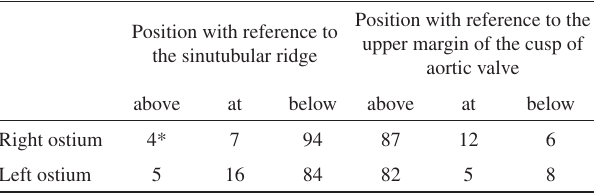
Table 2 - Positions of the coronary ostia with respect to the sinutubular ridge and the cusps of the aortic valve Position with reference to the sinutubular ridge